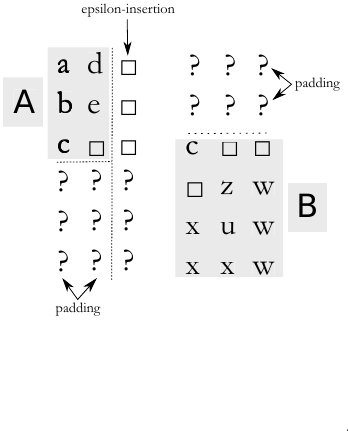
Figure 3: Illustration of multitape composition: the shaded areas show possible contents of the original multitape automata A and B , while the remaining areas show the result of insertions to coerce the automata to have the same dimensions and epsilon-behavior before intersection of A and